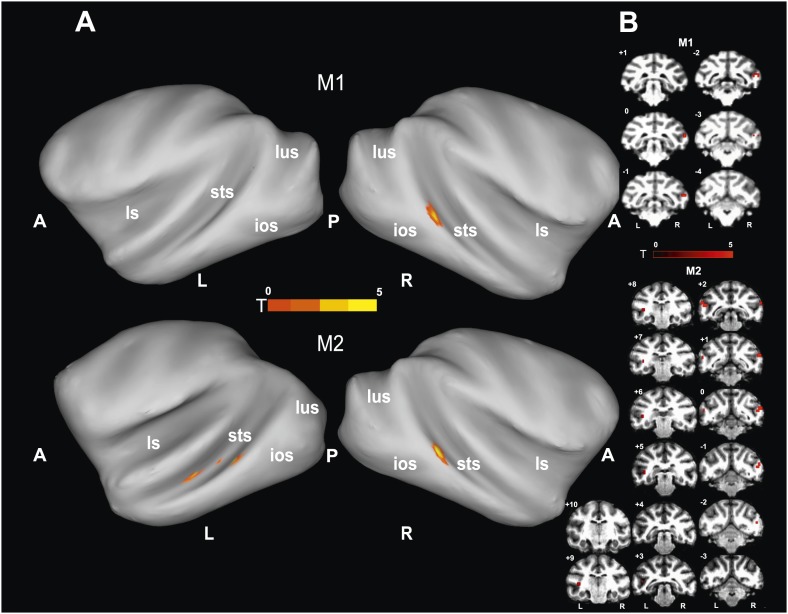
'Gaze following vs identity matching' BOLD contrast.(A) Lateral views of the partially inflated hemispheres of monkeys M1 and M2 with significant (p<0.005, uncorrected, 5 contiguous voxels) BOLD 'gaze following vs identity matching' contrasts. A = anterior, P = posterior, L = left, R = right, sts = superior temporal sulcus, ios = inferior occipital sulcus, lus = lunate sulcus, ls = lateral sulcus. (B) Coronal sections through the brains of monkeys M1 and M2 with corresponding significant BOLD contrast from (A). The color scale bar gives the t-scores indicating the size of significant BOLD contrasts. The numbers in the left corners of each section indicate the distance from the vertical interaural plane of each monkey. L = left, R = right.